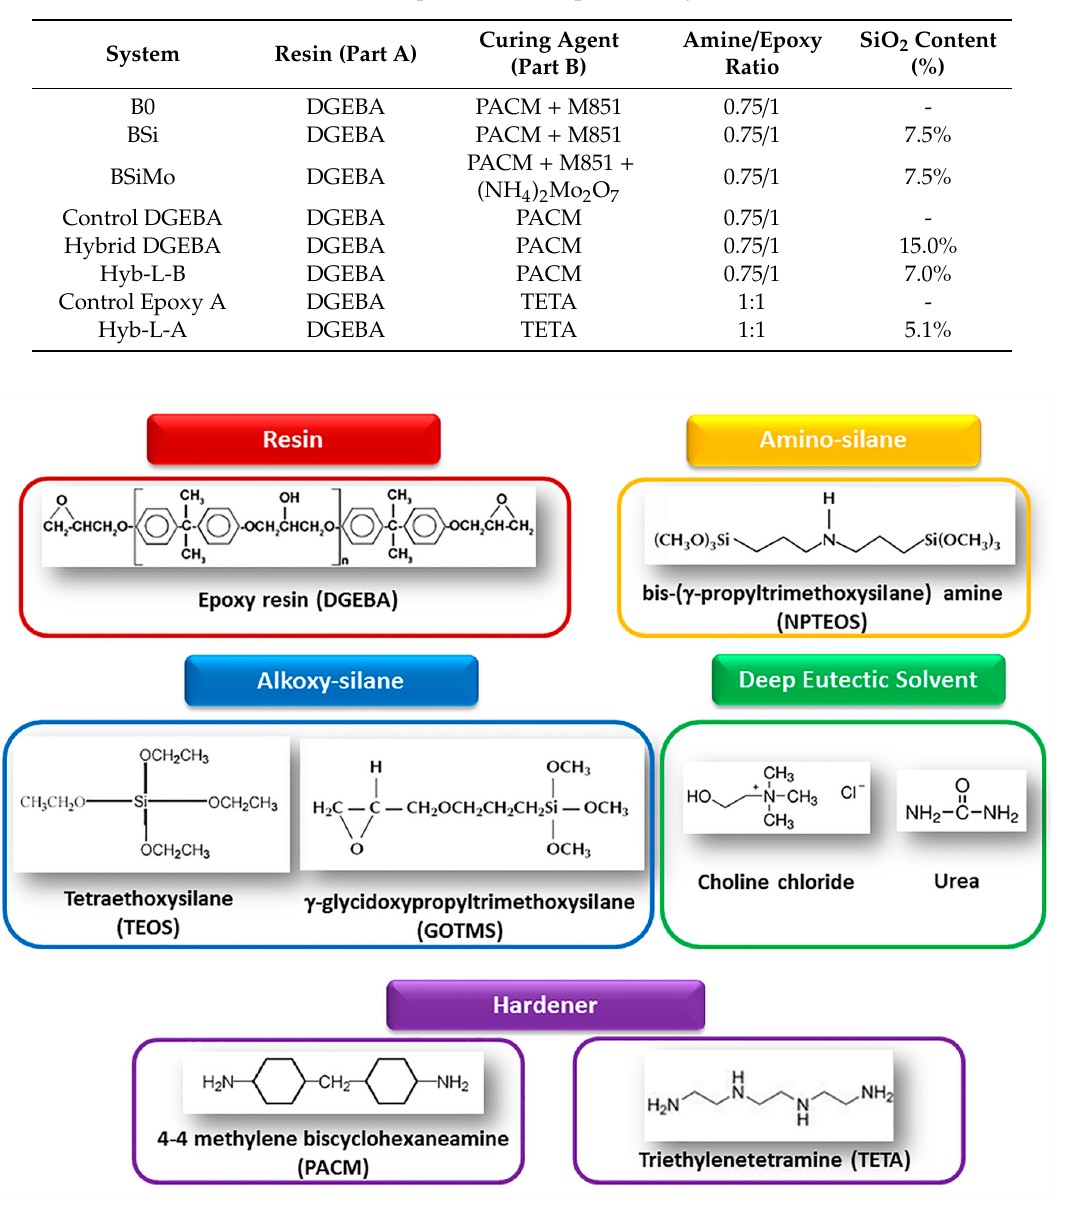
Table 1. Compositions of the produced